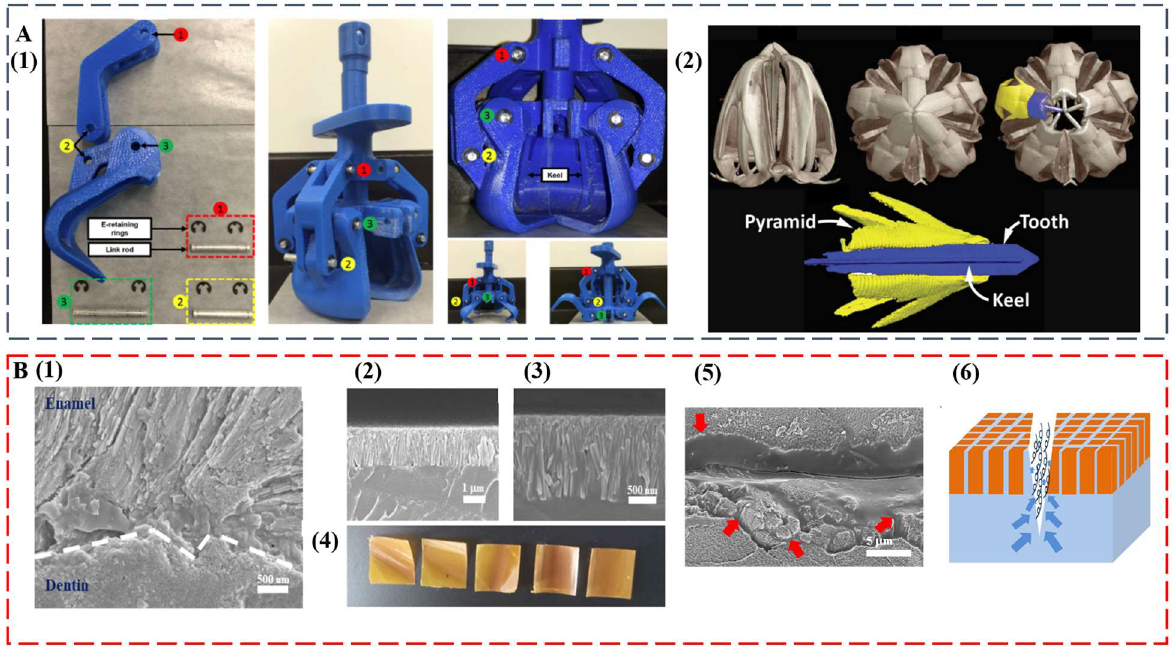
Figure 5. ( A ) A claw-like device inspired by sea urchin teeth. (1) Assembled 3D printed bioinspired Aristotle’s lantern parts. (2) Micro-computed tomography analysis of Aristotle’s lantern structure. Reproduced with permission from M.B. Frank et al. [98], MyJoVE Corporation. ( B ) A biomimetic tooth replicate that is hard, damage tolerant, and self-healing. (1) Human tooth enamel–dentin interface. (2 and 3) Low and high magnification cross-sectional SEM images of bilayer tooth replicate showing an interdigitated interface. (4) Optical images of bilayer tooth replicate with the nanocolumn layer on the top. (5) An SEM image of the crack after 10-min immersion in water (the red arrows indicate polymer diffusions from the bottom layer). (6) Schematic illustration of the upward polymer diffusion from the bottom layer. Reproduced with permission from Y. Yan et al. [104], Chinese Chemical Society.